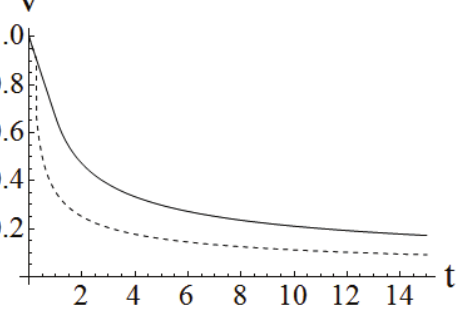
Figure 8. Graph of the volume, V , of molasses remaining plotted against time t at T = 60 ◦ C and T = 100 ◦